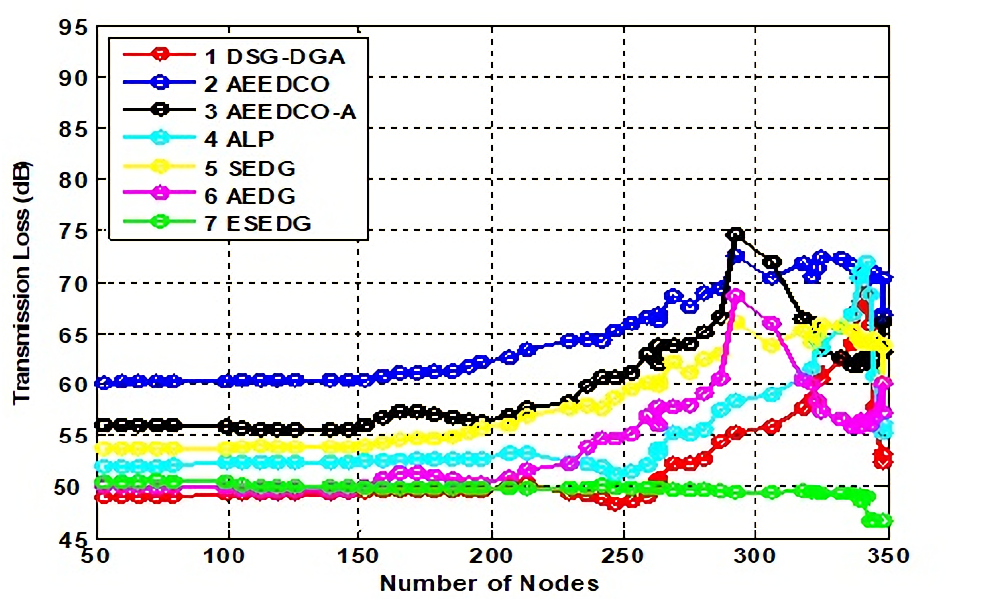
Figure 7. Analysis of transmission loss with baseline